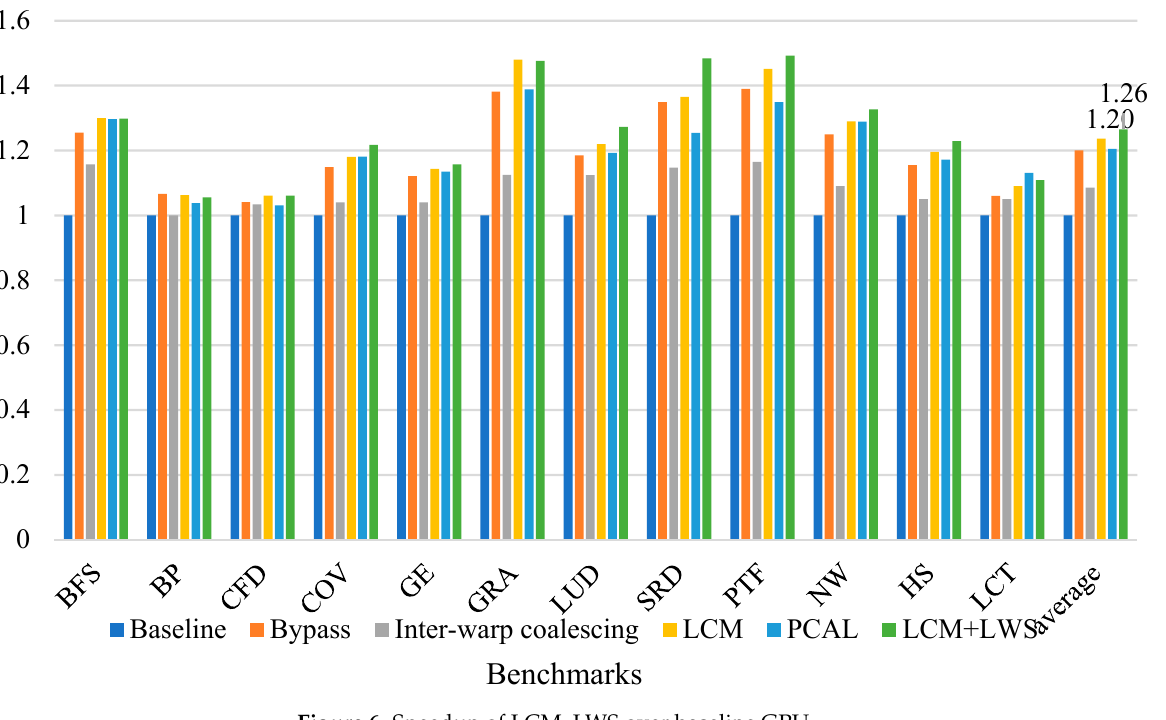
Figure 6. Speedup of LCM, LWS over baseline GPU.